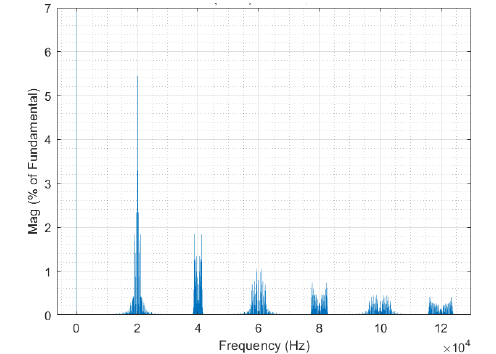
Figure 12. Spectrum of output voltage under the fixed PPDR .